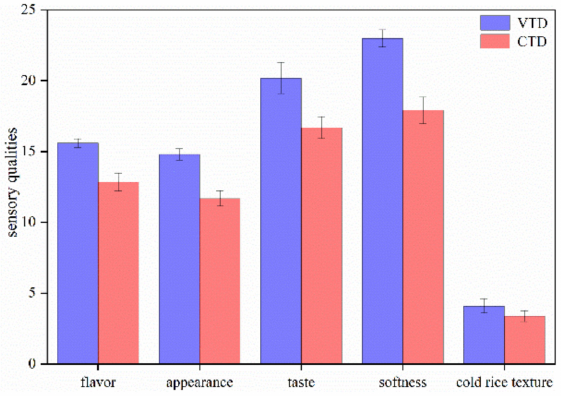
Figure 6. The sensory qualities of cooked